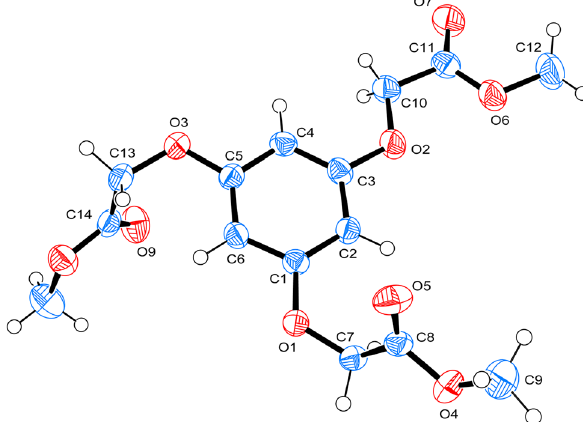
Table  : Data collection and